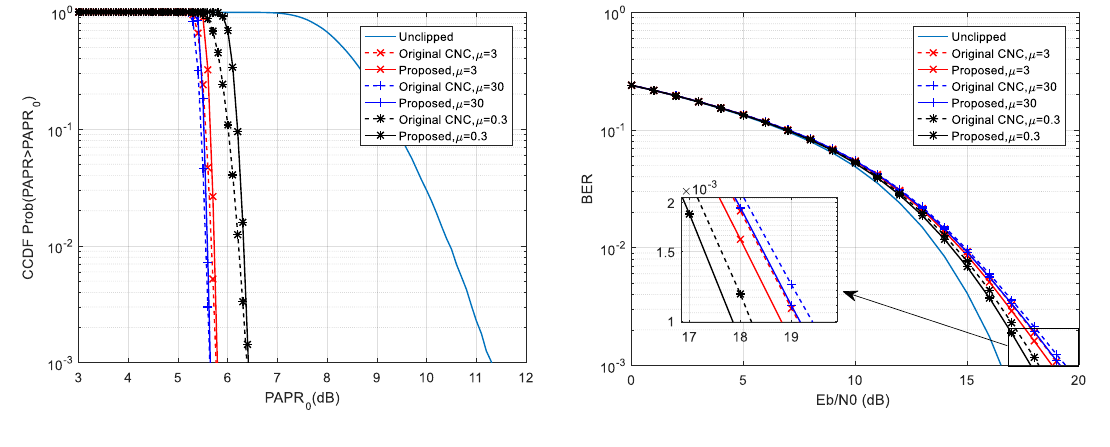
Figure 5. The CCDF probability of peak-to-average power ratio (PAPR) and bit-error-ratio (BER) performance of the original clipping noise compression (CNC) method and the proposed method with µ = 3, 30, 0.3, and α = 0.02, 0.02, 0.018 correspondingly, when N = 256, M = 64, and γ = 1.8